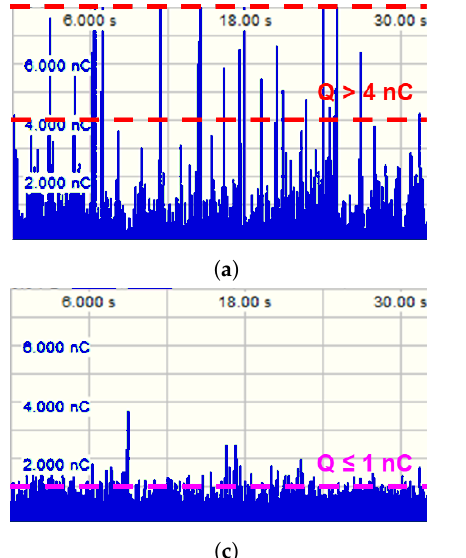
Figure 3. Diagrams of apparent charge magnitude vs. time acquired during negative DC IPT at − 3.4 kV. ( a ) Mobile discharges producing magnitudes greater than 4 nC. ( b ) Localized discharges producing magnitudes between 1 nC and 4 nC. ( c ) High temperature discharges having peak charge magnitude of 1